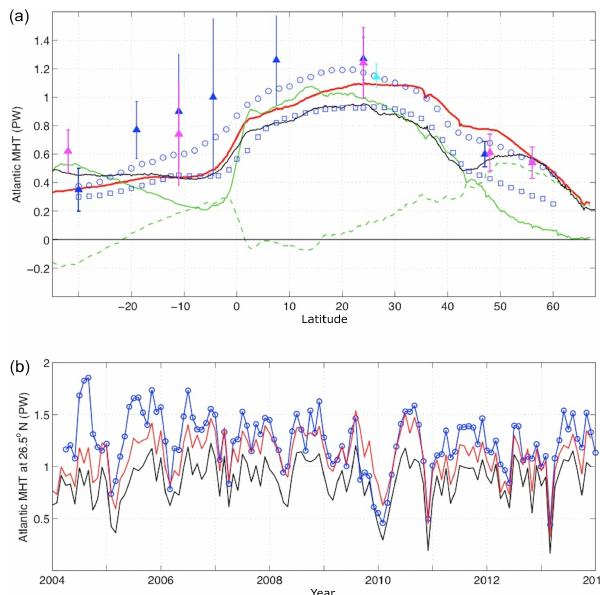
Figure 4. (a) Time-mean Atlantic meridional heat transport (MHT; in PW) as a function of latitude. Red line is the total GLOB16 trans- port with its overturning (green) and gyre (dashed green) compo- nents. Black line represents the total GLOB4 transport. Blue cir- cles (squares) represent implied time-mean transport calculated by Large and Yeager (2009; Trenberth and Fasullo, 2008). Triangles in- dicate direct estimates with their uncertainty ranges from the 2009– 2013 RAPID data (cyan), Ganachaud and Wunsch (2003) (blue), and Lumpkin and Speer (2007) (magenta). (b) Times series of the total Atlantic MHT across 26.5 ◦ N as estimated by RAPID (blue), GLOB16 (red), and GLOB4